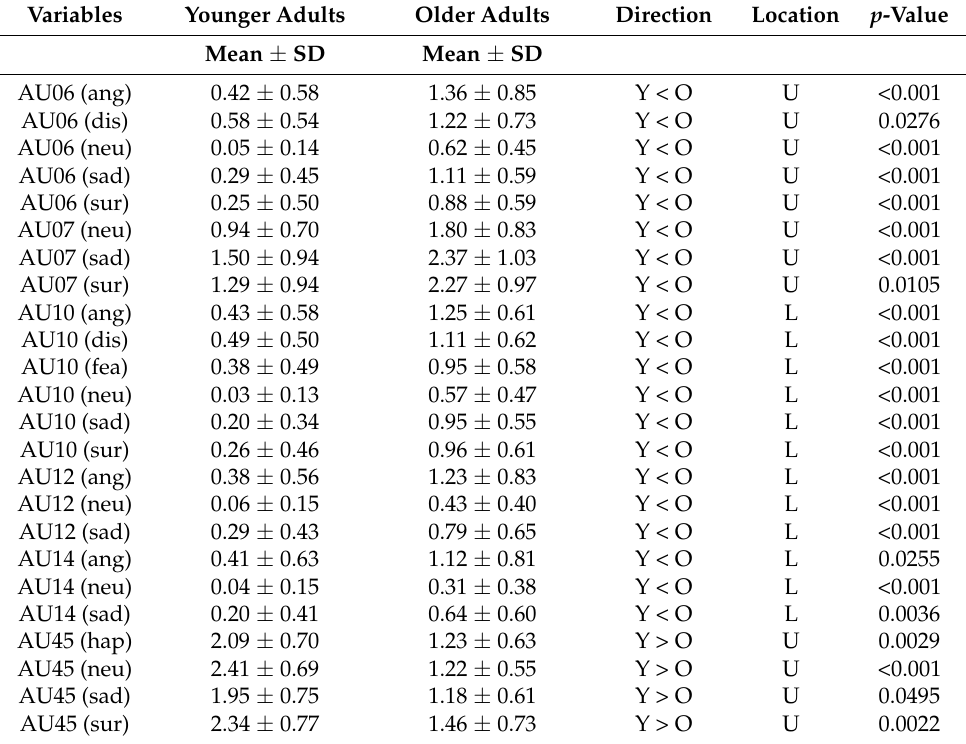
Figure 3. Prevalence of emotional AU values by groups for emotional face. AU, action unit. Table 3. AU comparisons by groups for six basic